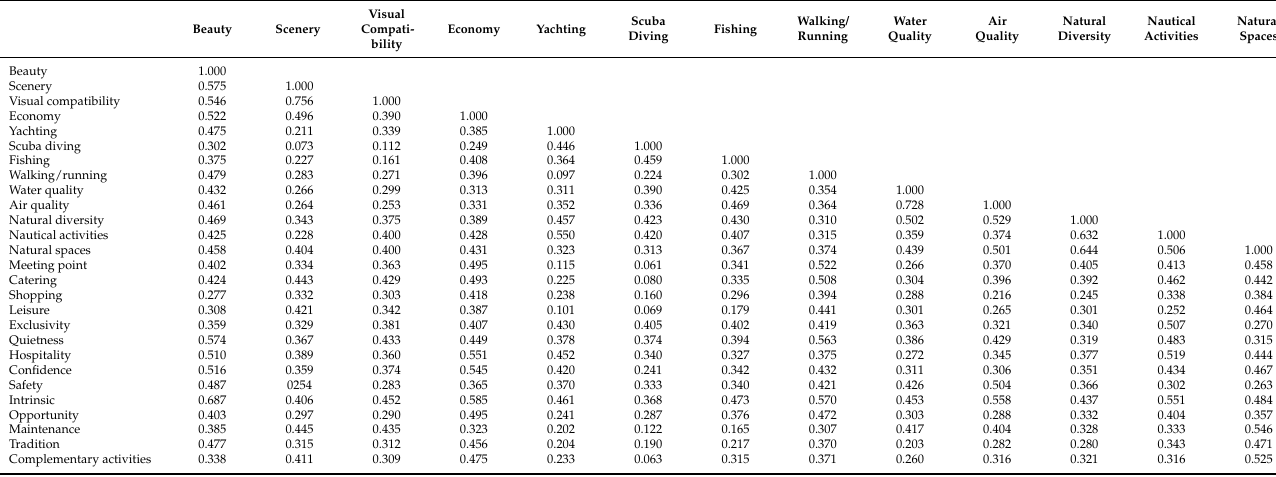
Table A3. Descriptive statistics for landscape